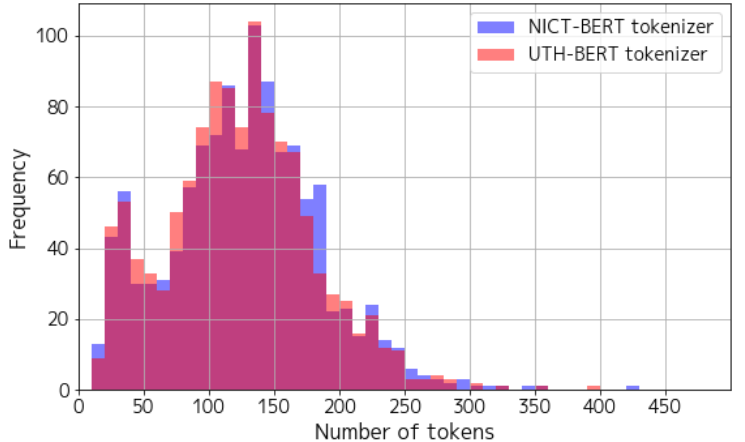
Figure 2. A histogram of the numbers of tokens in the short summary texts of medical accidents. The purple area is where the NICT-BERT tokenizer area shown in blue overlaps the UTH-BERT tokenizer area shown in red.